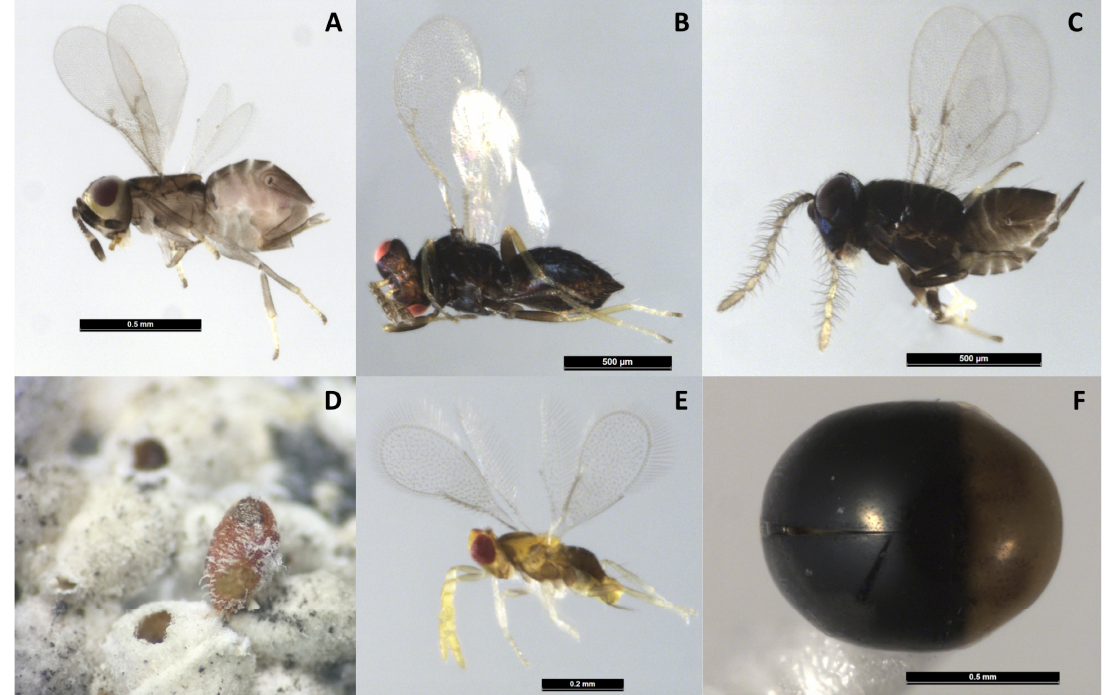
Figure 5. Parasitoids reared from Acanthococcus lagerstroemiae ( A – C ); caused damage in Beijing, China ( D ); the parasitoid reared in Louisiana, U.S. ( E ); and the predator, Cybocephalus nipponicus Endrody-Younga, reared from Acanthococcus lagerstroemiae in China ( F ). Voucher specimens of these natural enemies were deposited in Louisiana State Arthropod Museum at Louisiana State University.